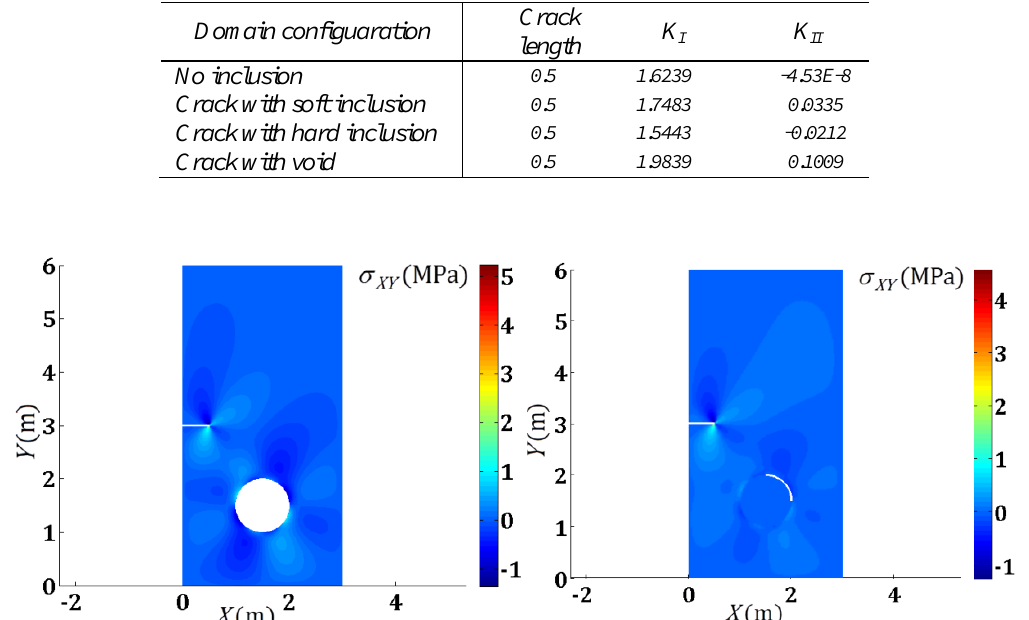
Table 2. The comparison between SIFs in the interaction with internal inclusions.